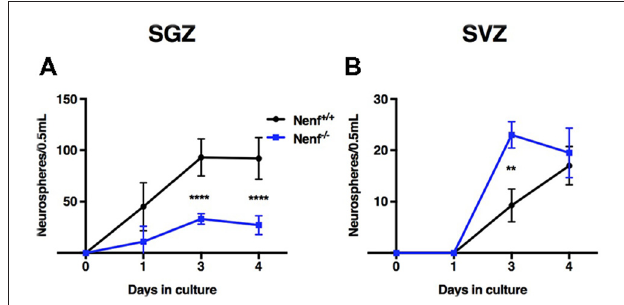
FIGURE 2 | In vitro hippocampal derived neural stem cells (NSCs) impaired self-renewal capacity in the absence of NENF. Primary neurospheres obtained from male pups were counted at days 1, 3 and 4 of culture. NSCs derived from hippocampus (SGZ) of NENF − / − mice formed significantly less spheres when compared with NENF + / + (A) but not in NSCs derived from SVZ ( B ). Data presented as Mean ± SEM; analyzed by two-way repeated measures ANOVA with a Bonferroni’s multiple comparisons post-test. ∗∗∗∗ p < 0.0001 for Nenf + / + vs. Nenf − / − for days 3 and 4 in the SGZ and ∗∗ p < 0.001 for Nenf + / + vs. Nenf − / − for days 3 in the